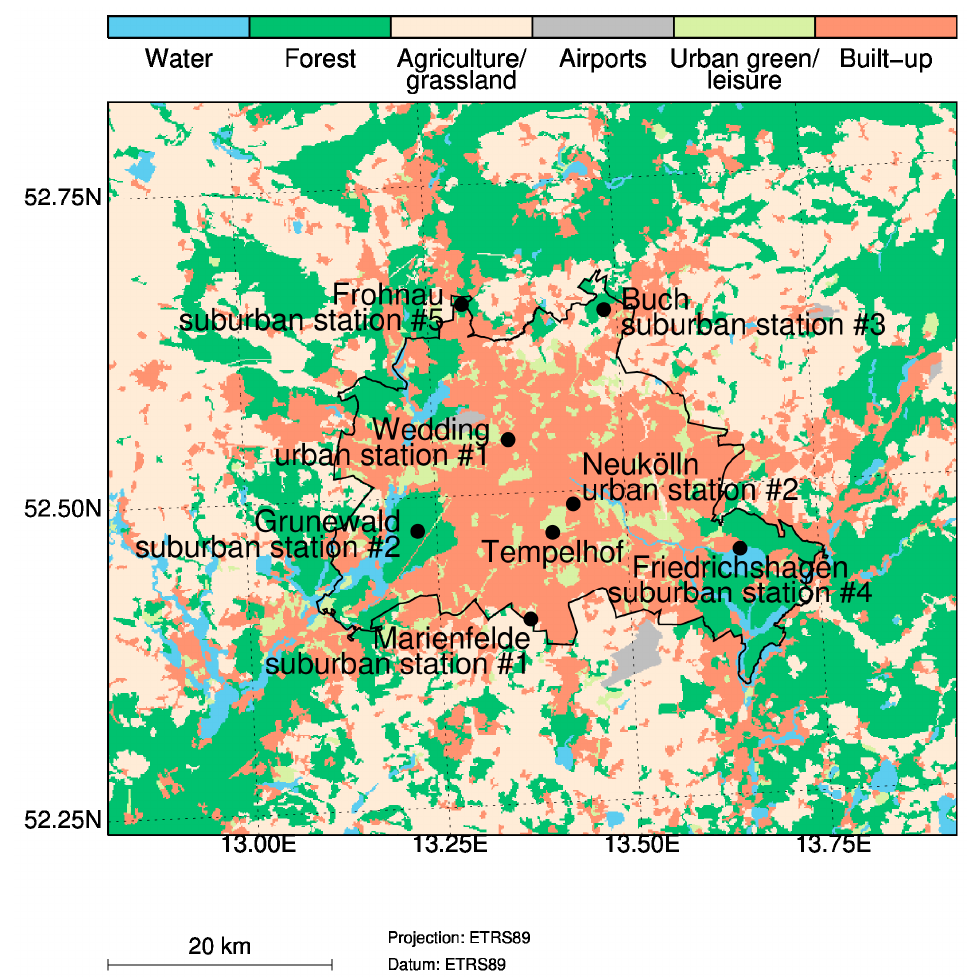
Figure 1. Study area and locations of observation sites of air temperature (Tempelhof) and ozone concentrations (Wedding, urban station #1; Neukölln, urban station #2; Marienfelde, suburban station #1; Grunewald, suburban station #2; Buch, suburban station #3; Friedrichshagen, suburban station #4; and Frohnau, suburban station #5) in Berlin. Land cover based on CORINE 2012, v18.5. The black line marks the administrative border of the city.